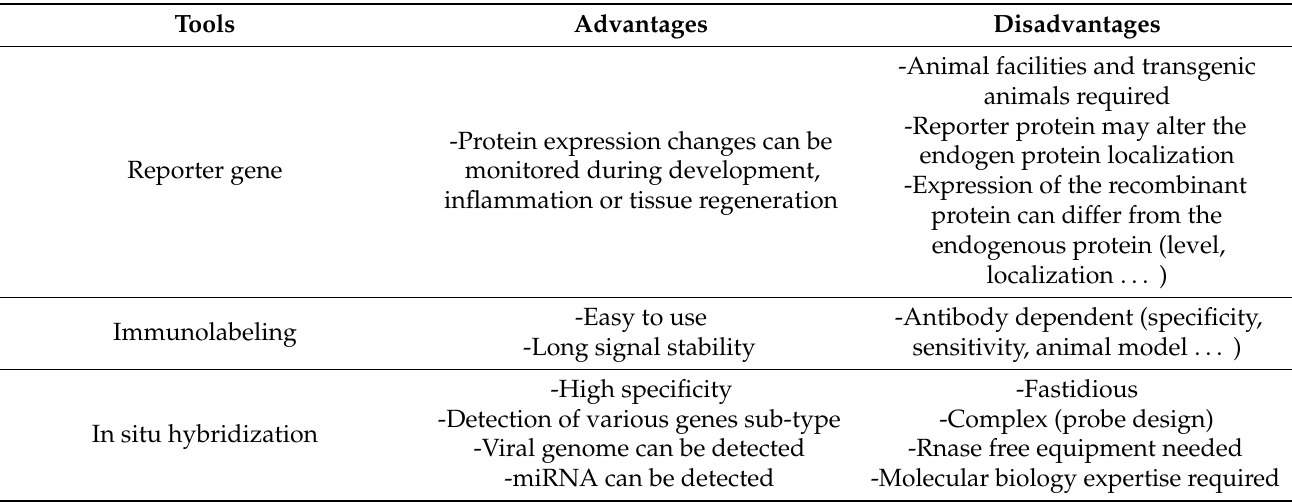
Table 1. Advantages and disadvantages of the different in situ